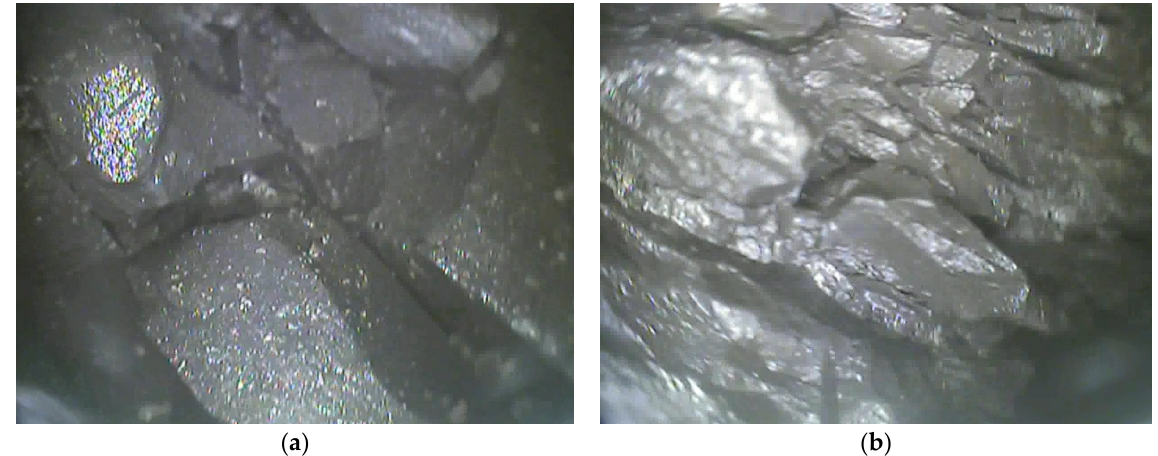
Figure 11. Observation in the vertical borehole (7 m) at a length of ( a ) 1.5 m and ( b ) 5.9 m.